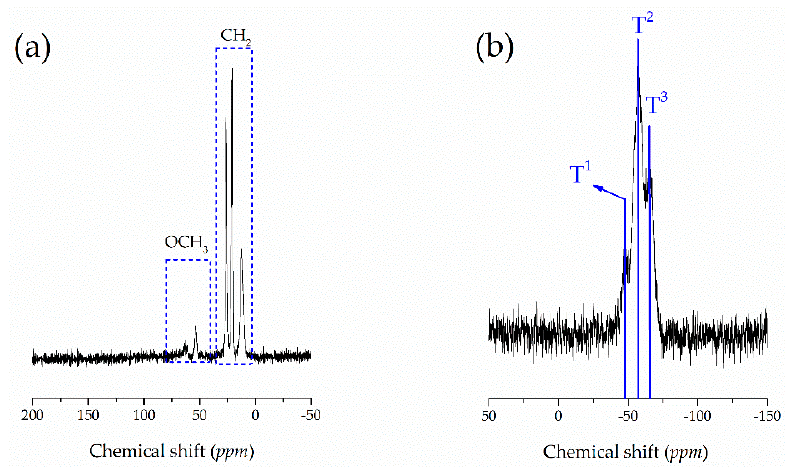
Figure 1. Solid state cross-polarization (CP)-magic angle spinning (MAS) NMR of the Al 2 O 3 nanowires (ANW) modified with (3-Aminopropyl)trimethoxysilane (APTMS). ( a ) 13 C and ( b ) 29 Si.